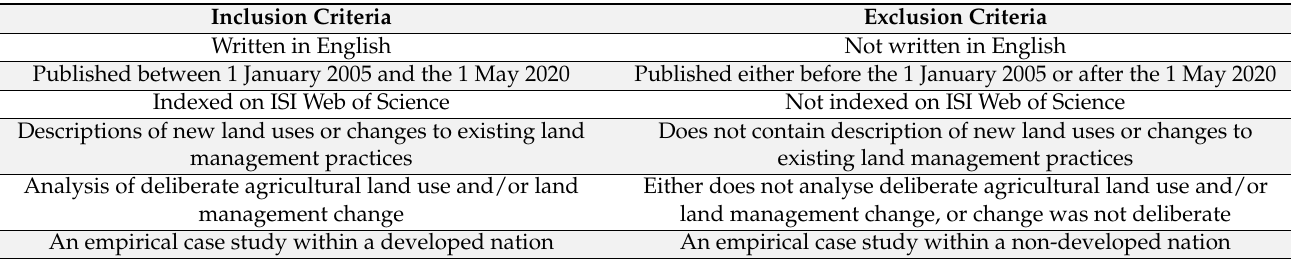
Table 1. Exclusion and Inclusion